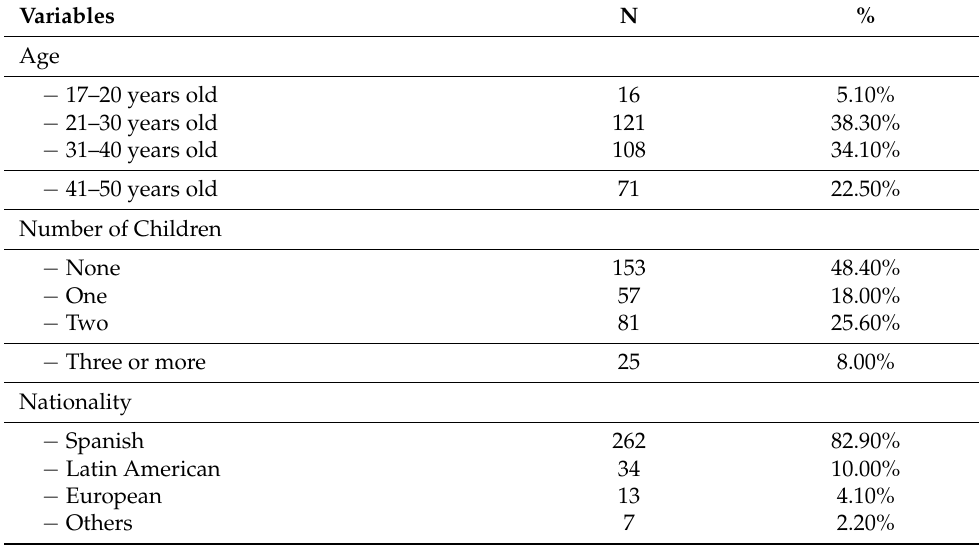
Table 1. Sociodemographic characteristics ( n =